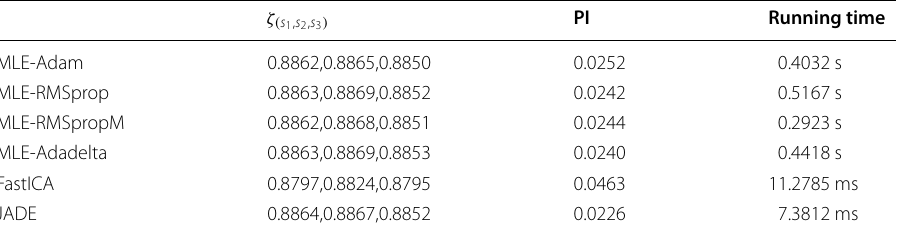
Table 4 The comparison between proposed method and typical ones in the form of ζ , PI and running time with SNR 10 dB and bits number equal to 1000 = ζ ( s 1 , s 2 , s 3